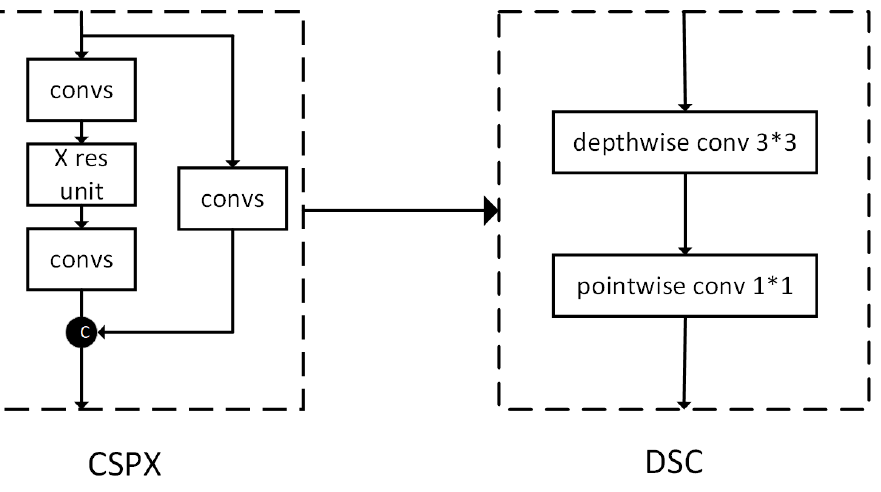
Figure 10. DSC module replaces CSP module.